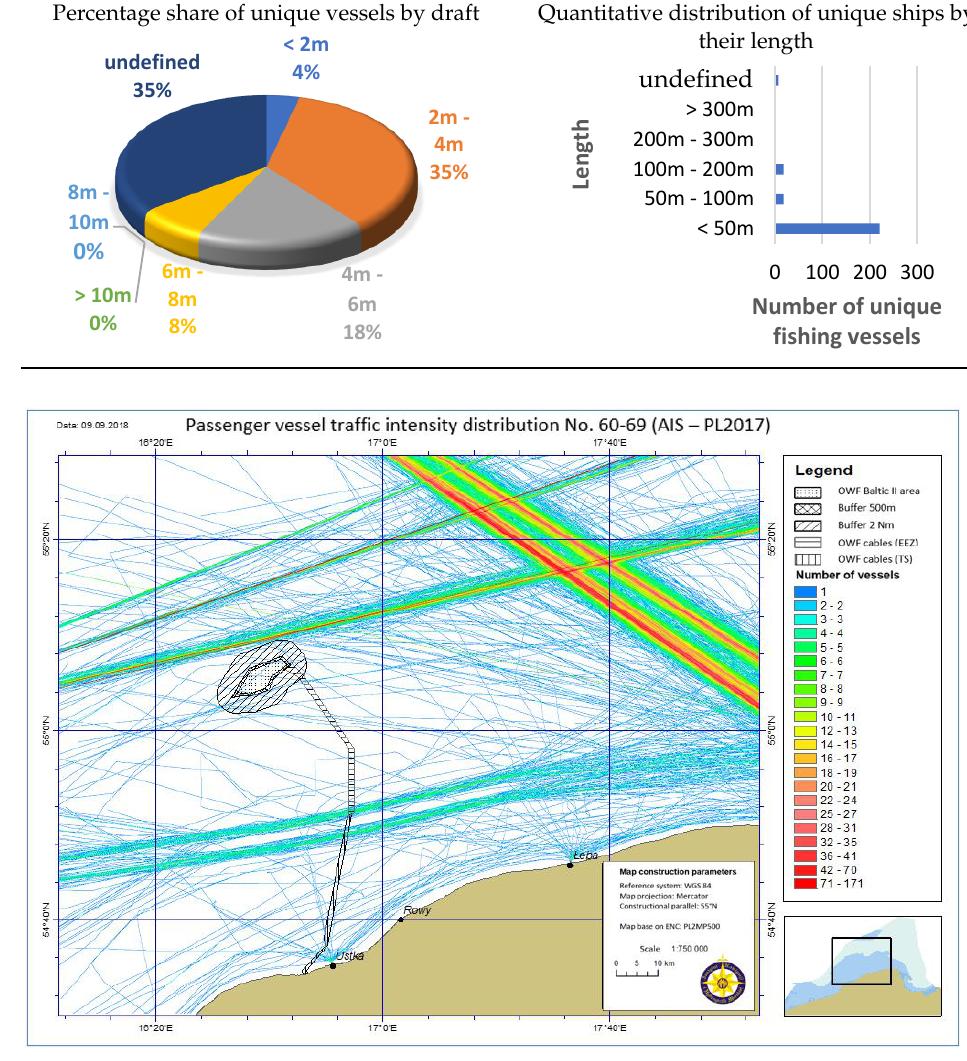
Figure 6. Distribution of passenger ship traffic intensity covering a large sea area around the OWF (ship type numbers: 60 – 69, AIS-PL 2017).